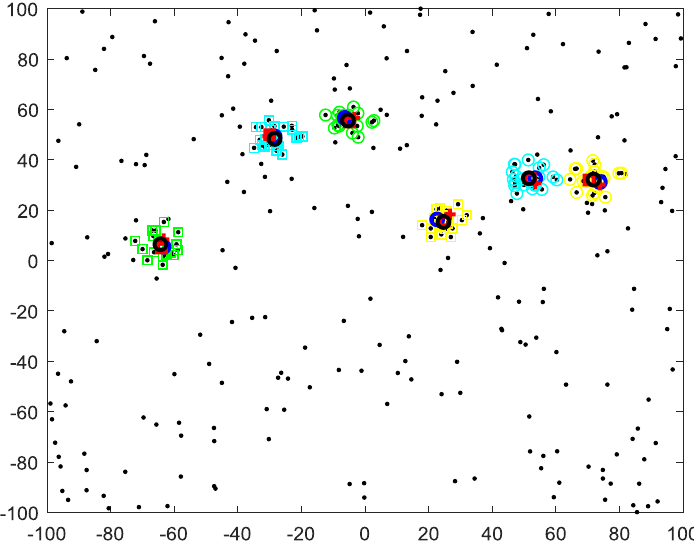
Figure 7. Trajectories of the targets with a fully unknown movement.